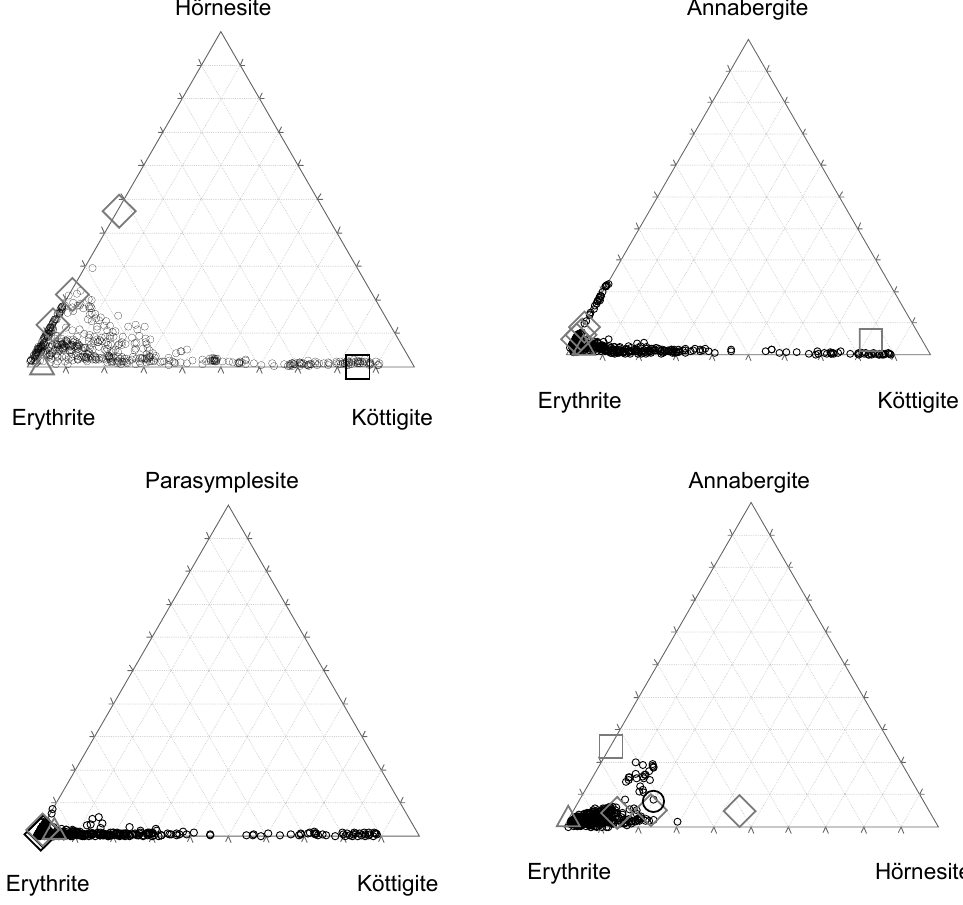
Figure 7. Ternary compositional plots for erythrites and köttigites from Miedzianka supplemented by data in the literature. Diamond—[10], triangle—[5], square—[6],